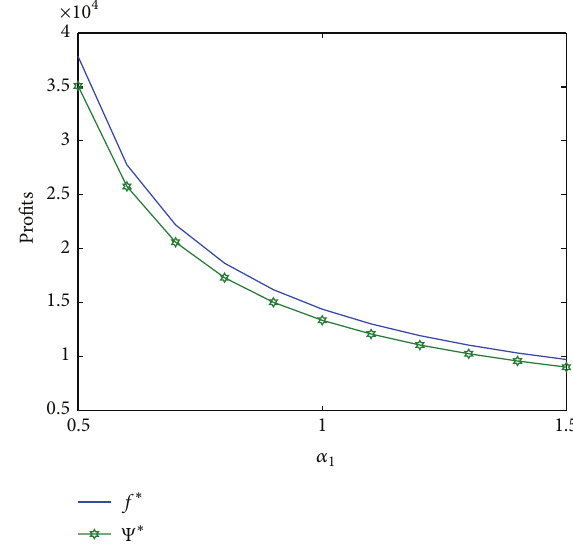
Figure 13: Impact of 𝜇 on the profits under demand certainty and uncertainty.